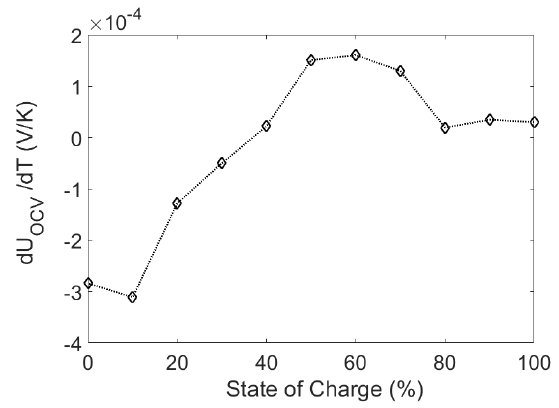
Figure 8. The experimentally determined values of dU ocv / dT c as a function of SOC.